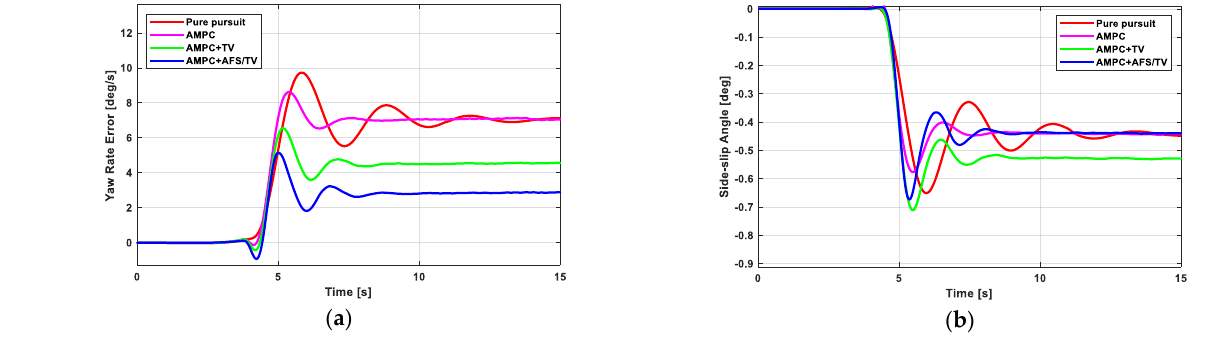
Figure 12. ( a ) Yaw rate error and ( b ) side-slip angle. Electronics 2021 , 9 , x FOR PEER REVIEW